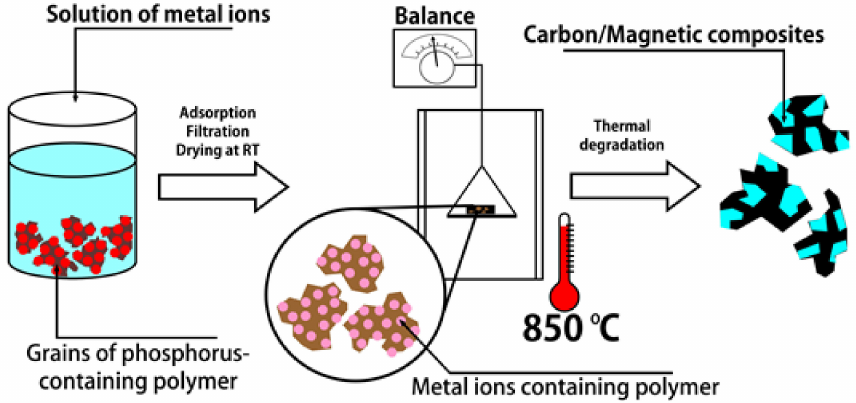
Scheme 1. Synthesis procedure of carbon/magnetic